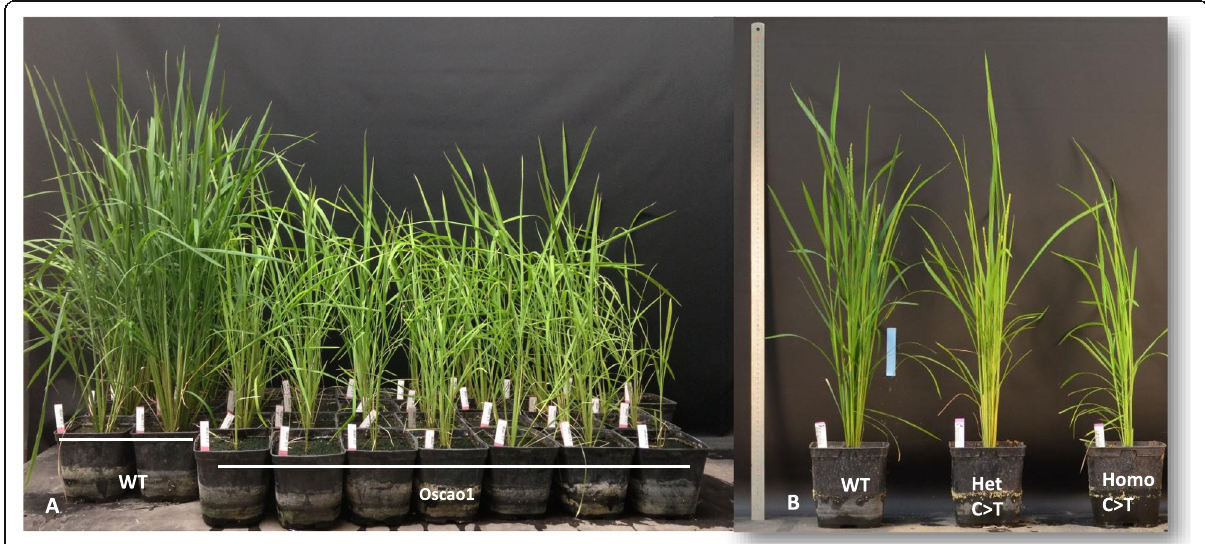
Fig. 4 Phenotypes associated with mutations generated by CAS9 (A) and BECAS9 (B). WT = wild type, Oscao1 = mutant induced by CAS9. (A) Twenty-nine mutants are visible among 33 mutant plants: yellow plants smaller than WT. (B) From left to right, a WT plant, a heterozygous C- > T plant, and a homozygous C- > T plant. The heterozygous and homozygous plants have a pale-yellow phenotype, as expected, and the homozygous plant is shorter than the heterozygous plant and the